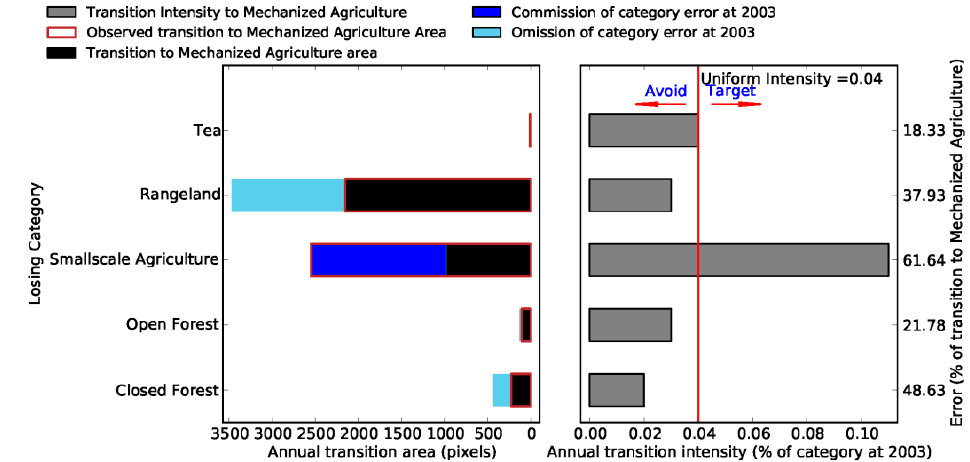
Figure 4. Transition to mechanized agriculture (2003–2014 interval) .